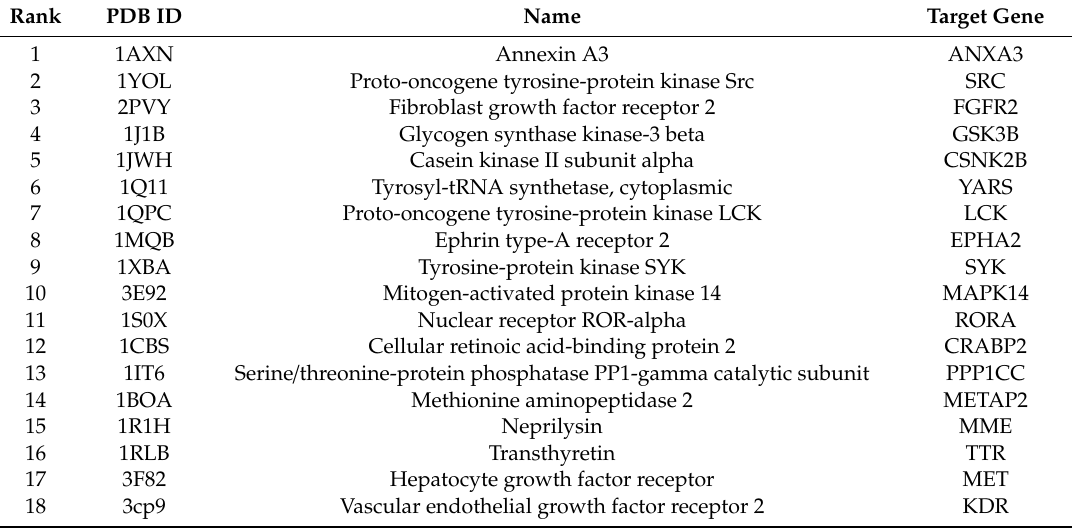
Table 4. Putative targets of RA identified by PharmMapper and